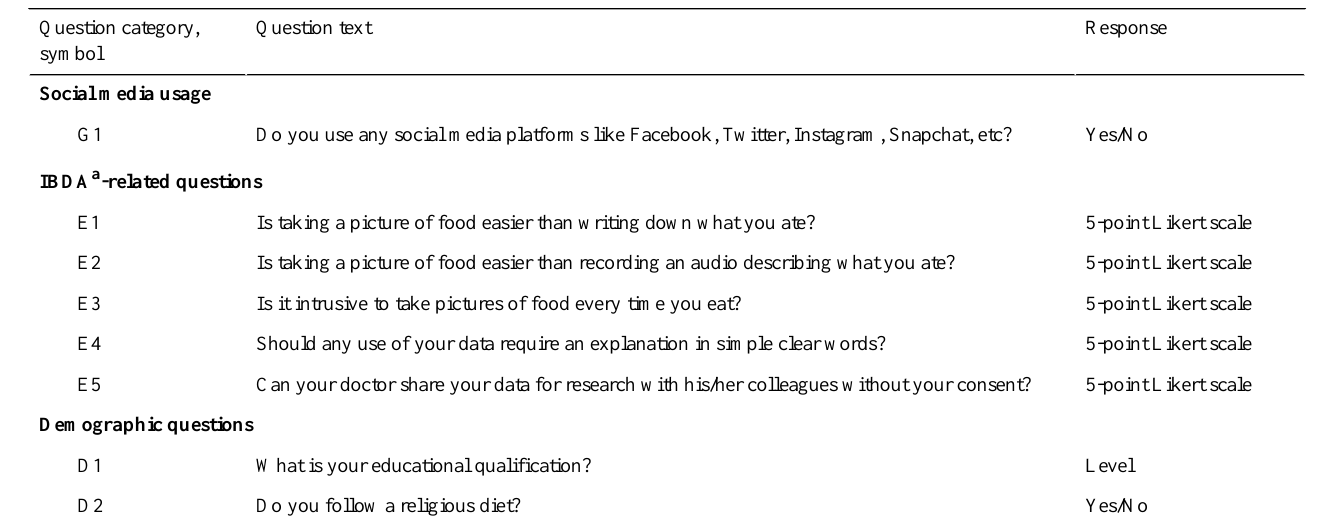
Table 1. Few questions from the questionnaire with their possible